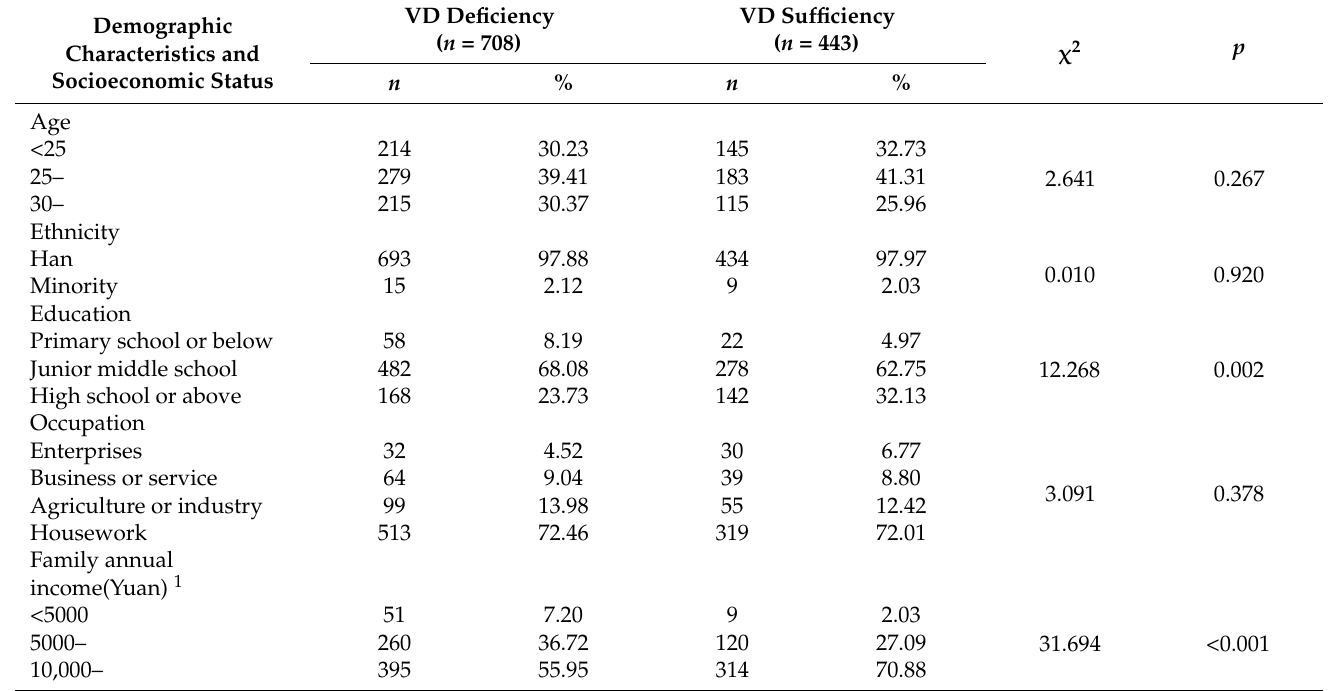
Table 1. Demographic characteristics and socioeconomic status between VD deficiency and VD sufficiency